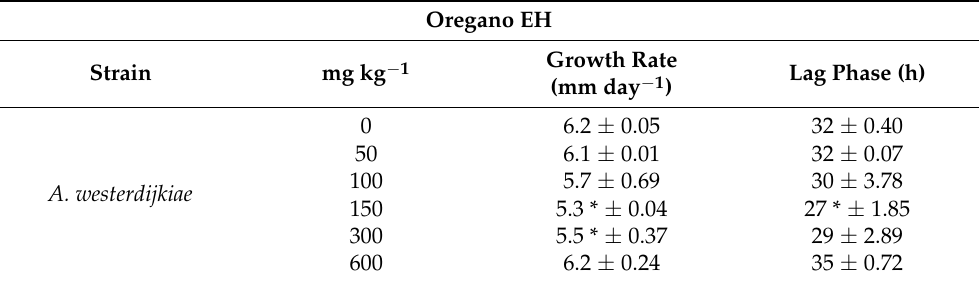
Table 6. Effect of oregano hexanic plant extraction on lag phase and growth rate of A. westerdijkiae at different concentrations.